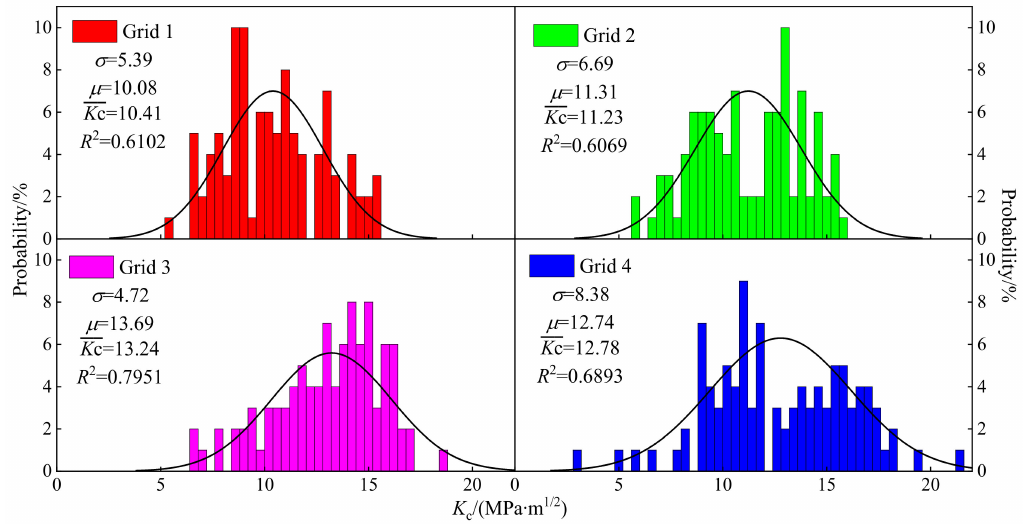
Figure 9. Frequency distribution histogram of K c . The closer the value of R 2 is to 1, the better the fit of the regression line to the observed values; on the contrary, the smaller the value of R 2 , the worse the fit of the regression line to the observed